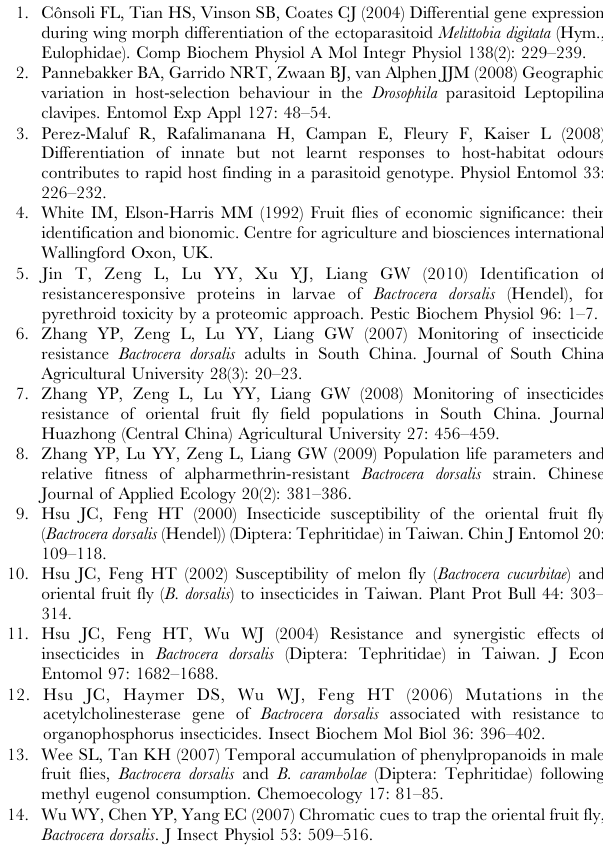
Table S2 The Pfam domain search of S. endius transcripts. Table S3 The summary of KEGG enrichment in S. endius -specific sequences. Table S4 The summary of GO enrichment in S. endius - specific sequences. Table S5 The putative chemoreceptor superfamily transcripts in S. endius . Table S6 cSSR information derived from all tran- scripts. Table S7 cSSR primer